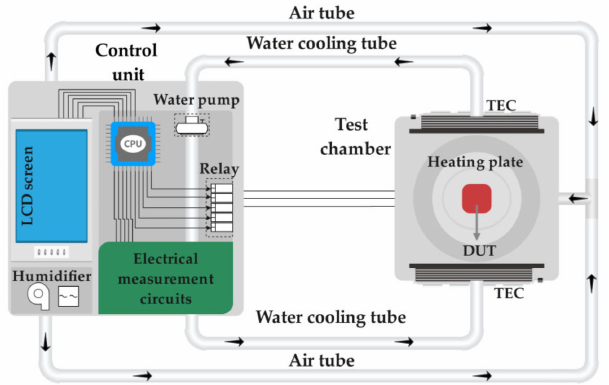
Figure 1. Schematic illustration of the miniaturized reliability test system with controlled environ- ment